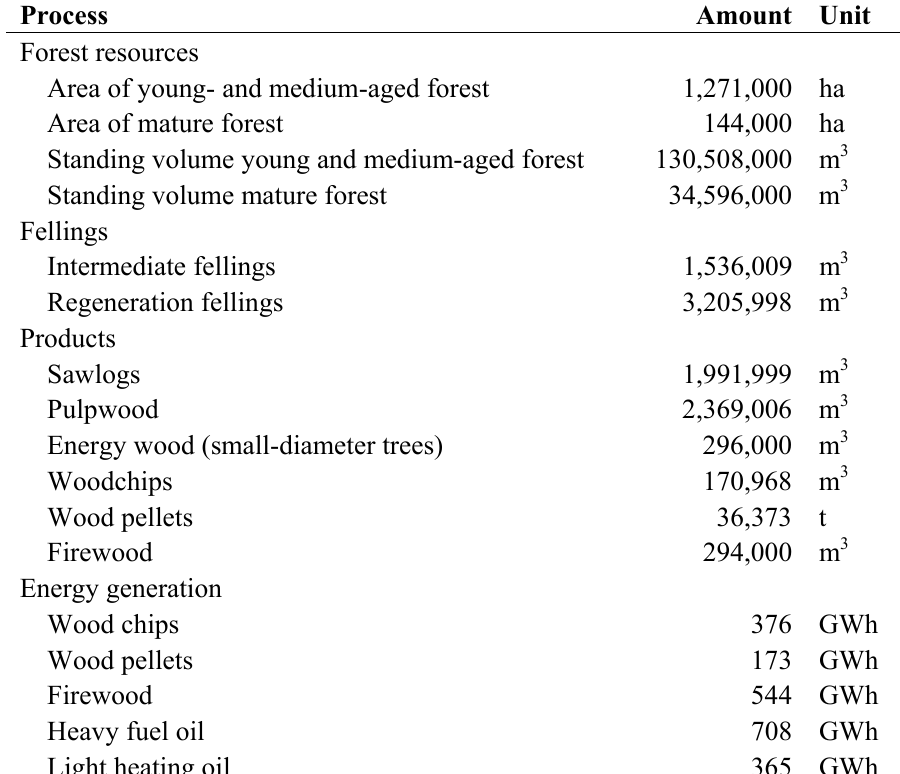
consumption in North Karelia in